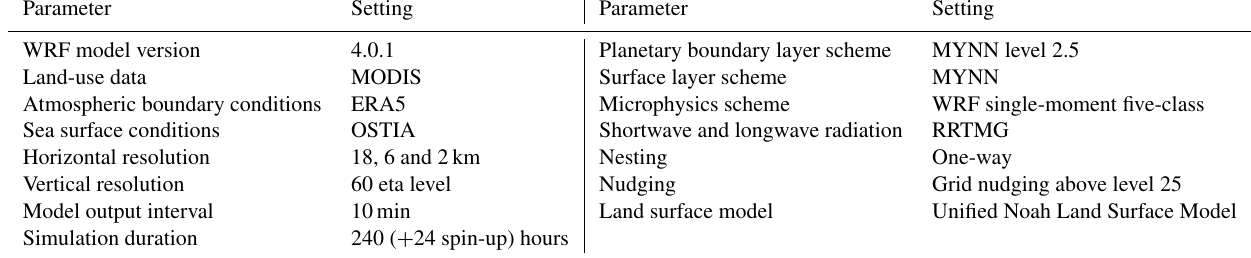
Table 2. Relevant parameters of the setup for the mesoscale simulations applied in this study. The references for the different schemes and models are summarised in WRF Users Page (2020).